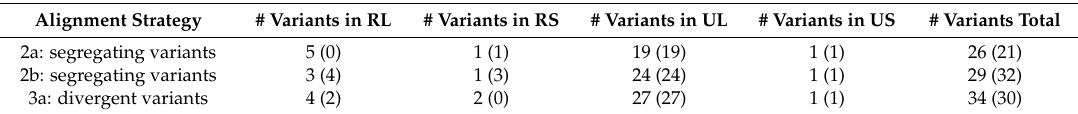
Table 4. Reference variant calling vs. de novo variant calling. Number of variants identified using the indicated alignment strategy (as indicated in Figure 6) for variants called against the HSV1 NR-ref or the HSV1 reference (in